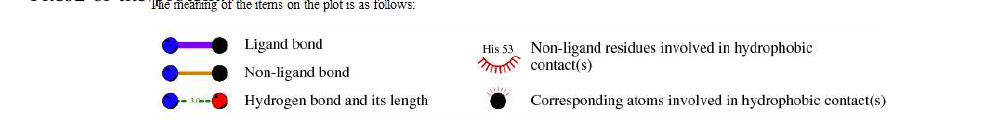
Figure 2: Protein-ligand interaction of complex Dihydrofolate Reductase_3,7,11,15-Tetramethyl-2-hexadecen- 1-ol Note: In the interaction between Dihydrofolate Reductase (protein) and 3,7,11,15-Tetramethyl-2-hexadecen- 1-ol (ligand), the ligand form two hydrogen bonds (represented as broken lines with bond length) with amino acid Asn69 and Phe82 of the